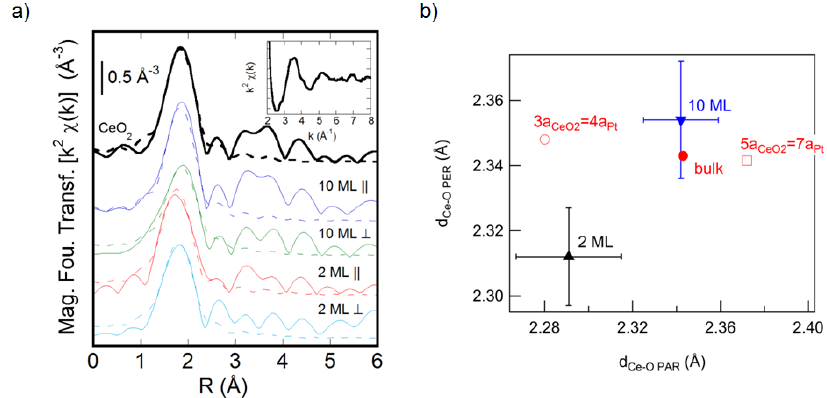
Figure 2. ( a ) Modulus of the Fourier transform of the k 2 -weighted Ce L edge χ (k) (solid lines) and first shell fits (dashed lines) for the CeO 2 reference sample and for 10 ML and 2 ML CeO 2 films on Pt(111) with the electric field parallel and perpendicular to the film surface. The inset shows the Ce L edge raw χ (k) data for the 10 ML film. ( b ) Ce-O interatomic distances parallel (d Ce-O PAR ) and perpendicular (d Ce-O PER ) to the film surface for a 2 ML (black triangle) and for a 10 ML (blue triangle) cerium oxide film grown on Pt(111), obtained from the fitting of the spectra in ( a ). The experimental values are compared with the values measured on the CeO 2 reference sample (red dot) and with the values expected under the hypotheses of 3:4 (red open circle) and 5:7 (red open square) coincidence, assuming the bulk elastic constants. Reprinted from Luches et al. [31] with permission.